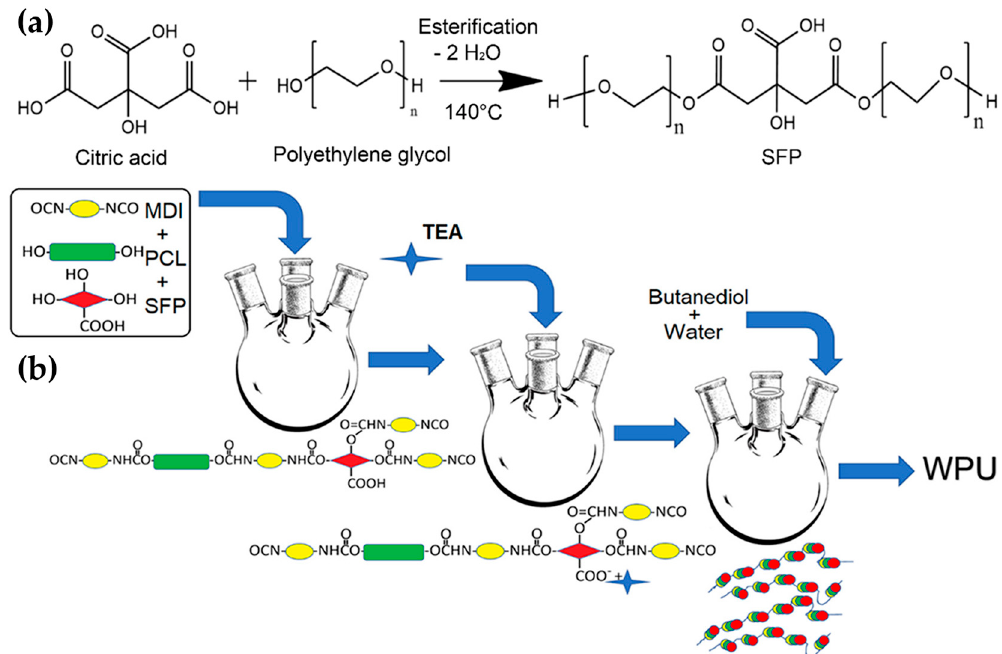
Figure 16. Schematic preparation of the SFP from CTA and PEG200 ( a ) and subsequent synthesis of the waterborne polyurethane ( b ) (MDI = 4,4 ′ -methylenebisphenyl diisocyanate; PCL = polycaprolactone diol 2000; TEA = triethylamine). Reprinted with permission Ref. [69]. Copyright 2019, I. Bramhecha, Ind. Eng. Chem. Res., American Chemical Society.